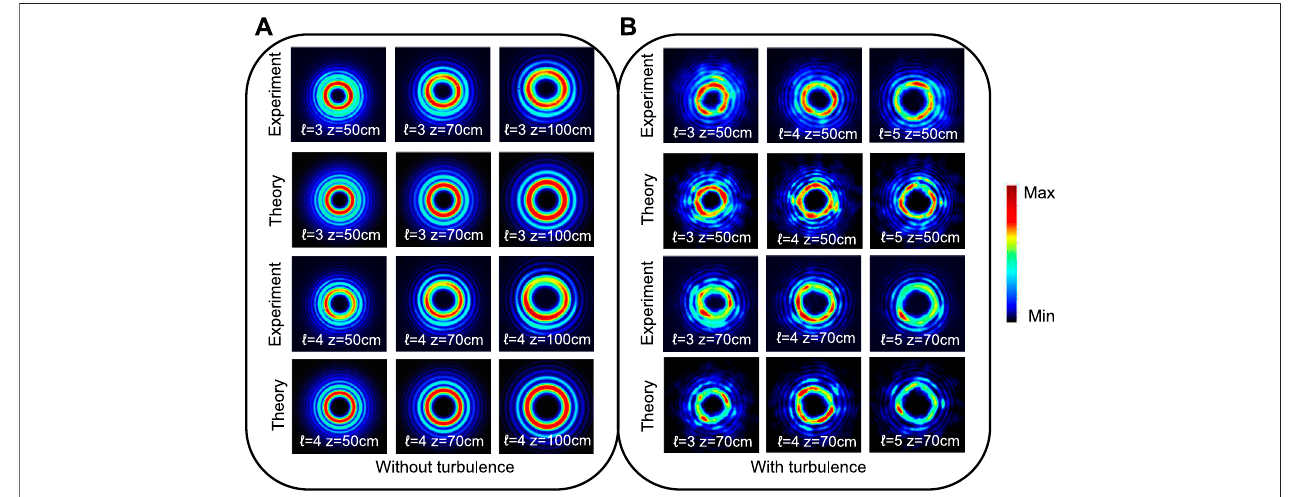
FIGURE 2 | The spatial pro fi les of different vortex beams. We show the experimentally measured images and simulated images for different topological charges ℓ and different propagation distances z , without turbulence in (A) and with turbulence in (B) . The fi rst and third rows are theimages acquired from theexperiment, and the second and fourth rows represent the theoretically simulated